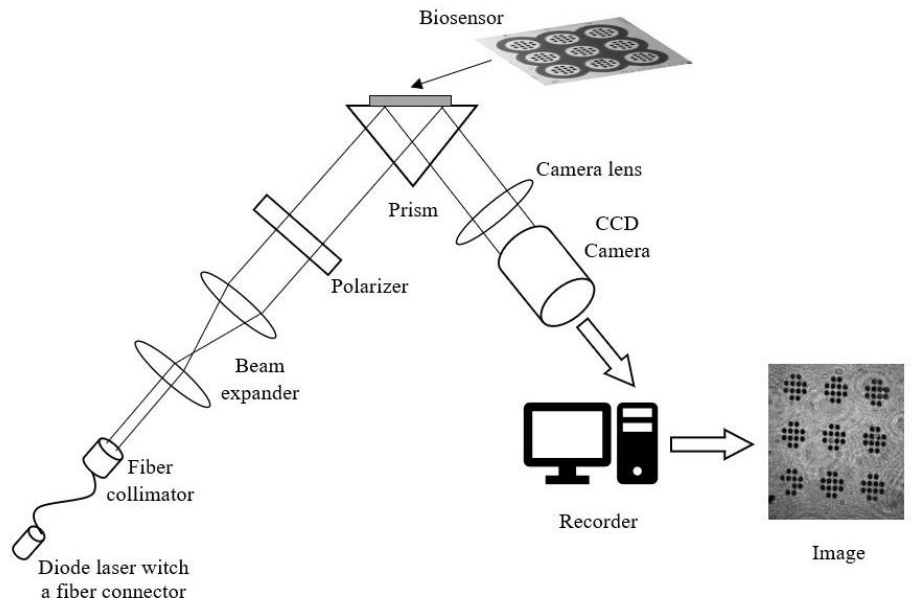
Figure 3. Sketch of SPRi apparatus.